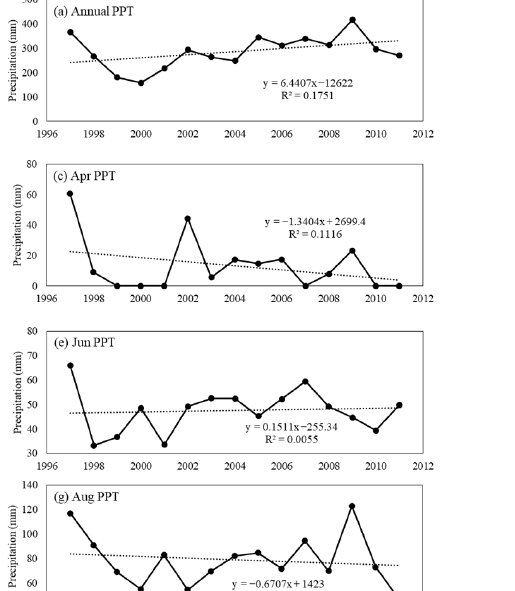
Figure A3. Variations of effective precipitation in crucial periods of different species during 1997– 2011. (a) Poa crymophila Keng; (b) Koeleria cristata ; (c) Kobresia humilis . References 1. Jiao, W.; Wang, L.; Smith, W.K.; Chang, Q.; Wang, H.; D’Odorico, P. Observed Increasing Water Constraint on Vegetation Growth over the Last Three Decades. Nat. Commun. 2021 , 12 , 3777. https://doi.org/10.1038/s41467-021-24016-9. 2. Wang, S.; Zhang, Y.; Ju, W.; Chen, J.; Ciais, P.; Cescatti, A.; Sardans, J.; Janssens, I.; Wu, M.; Berry, J.; et al. Recent Global Decline of CO 2 Fertilization Effects on Vegetation Photosynthesis. Science 2020 , 370, 1295–1300. https://doi.org/10.1126/science.abg8637. 3. Anderson, R.; Canadell, J.; Randerson, J.; Jackson, R.; Hungate, B.; Baldocchi, D.; Ban-Weiss, G.; Bonan, G.; Caldeira, K.; Cao, L.; et al. Biophysical Considerations in Forestry for Climate Protection. Front. Ecol. Environ. 2011 , 9 , 174–182. https://doi.org/10.1890/090179. 4. Cramer, W.; Bondeau, A.; Woodward, F.I.; Prentice, I.C.; Betts, R.A.; Brovkin, V.; Cox, P.M.; Fisher, V.; Foley, J.A.; Friend, A.D.; et al. Global Response of Terrestrial Ecosystem Structure and Function to CO 2 and Climate Change: Results from Six Dynamic Global Vegetation Models: Ecosystem dynamics, CO 2 and climate change. Glob. Change Biol. 2001 , 7 , 357–373. https://doi.org/10.1046/j.1365-2486.2001.00383.x. 5. Nemani, R.R.; Keeling, C.D.; Hashimoto, H.; Jolly, W.M.; Piper, S.C.; Tucker, C.J.; Myneni, R.B.; Running, S.W. Climate-Driven Increases in Global Terrestrial Net Primary Production from 1982 to 1999. Science 2003 , 300 , 1560–1563. https://doi.org/10.1126/science.1082750. 6. Bardgett, R.D.; Bullock, J.M.; Lavorel, S.; Manning, P.; Schaffner, U.; Ostle, N.; Chomel, M.; Durigan, G.; Fry, E.L.; Johnson, D.; et al. Combatting Global Grassland Degradation. Nat. Rev. Earth Environ. 2021 , 2 , 720–735. https://doi.org/10.1038/s43017-021- 00207-2. 7. Shi, Y.; Wang, Y.; Ma, Y.; Ma, W.; Liang, C.; Flynn, D.F.B.; Schmid, B.; Fang, J.; He, J.-S. Field-Based Observations of Regional- Scale, Temporal Variation in Net Primary Production in Tibetan Alpine Grasslands. Biogeosciences 2014 , 11 , 2003–2016. https://doi.org/10.5194/bg-11-2003-2014. 8. Silva, C.A.; Duncanson, L.; Hancock, S.; Neuenschwander, A.; Thomas, N.; Hofton, M.; Fatoyinbo, L.; Simard, M.; Marshak, C.Z.; Armston, J.; et al. Fusing Simulated GEDI, ICESat-2 and NISAR Data for Regional Aboveground Biomass Mapping. Remote Sens. Environ. 2021 , 253 , 112234. https://doi.org/10.1016/j.rse.2020.112234. 9. Scurlock, J.M.O.; Johnson, K.; Olson, R.J. Estimating Net Primary Productivity from Grassland Biomass Dynamics Measure- ments: Net primary productivity of grasslands. Glob. Change Biol. 2002 , 8 , 736–753. https://doi.org/10.1046/j.1365- 2486.2002.00512.x. 10. Lovell, J.T.; MacQueen, A.H.; Mamidi, S.; Bonnette, J.; Jenkins, J.; Napier, J.D.; Sreedasyam, A.; Healey, A.; Session, A.; Shu, S.; et al. Genomic Mechanisms of Climate Adaptation in Polyploid Bioenergy Switchgrass. Nature 2021 , 590 , 438–444. https://doi.org/10.1038/s41586-020-03127-1. 11. Ma, Z.; Liu, H.; Mi, Z.; Zhang, Z.; Wang, Y.; Xu, W.; Jiang, L.; He, J.-S. Climate Warming Reduces the Temporal Stability of Plant Community Biomass Production. Nat. Commun. 2017 , 8 , 15378. https://doi.org/10.1038/ncomms15378. 12. Knapp, A.; Smith, M. Interannual Variability in Net Primary Production and Precipitation—Response. Science 2001 , 293 , 1723. 13. Knapp, A.K.; Smith, M.D. Variation Among Biomes in Temporal Dynamics of Aboveground Primary Production. Science 2001 , 291 , 481–484. https://doi.org/10.1126/science.291.5503.481.